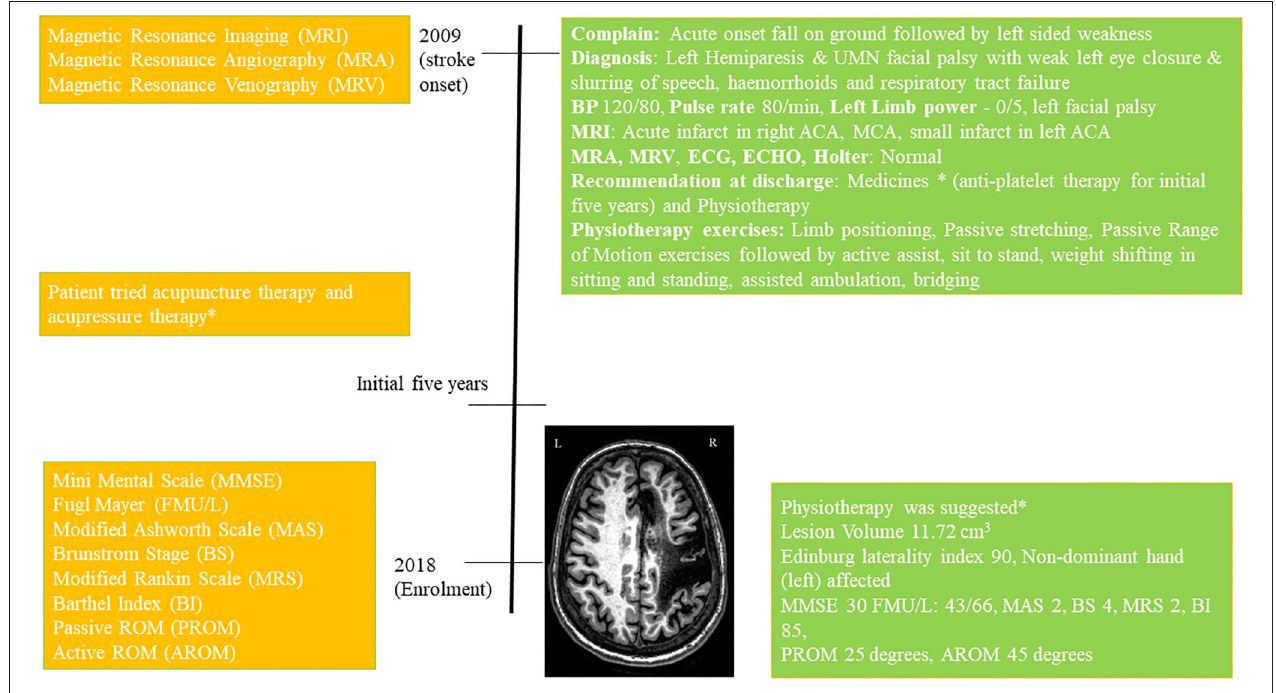
FIGURE 1 | Timeline with relevant data from the episode of care, *details in Supplementary Material